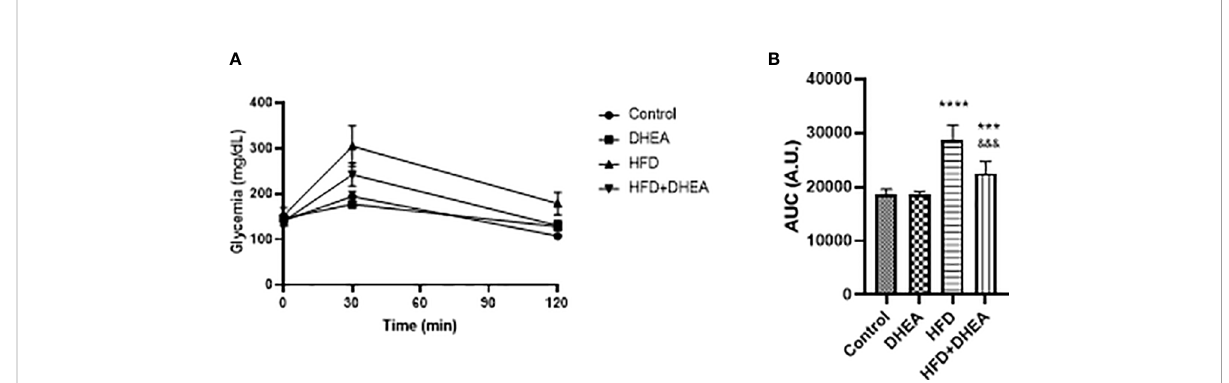
FIGURE 2 Effects of DHEA supplementation on glucose intolerance induced by HFD. Glucose tolerance test (A) and area under the curve (B) . Mice were fasted for 12h and oral glucose solution (80% w/v) was administrated at a dose of 2 g/kg body weight. Data are means of plasma glucose levels (mg/dl) ± SEM ( n = 9). *** P < 0.001, **** P < 0.0001 versus C and &&& P < 0.001 versus HFD according to one-way ANOVA analysis with multiple